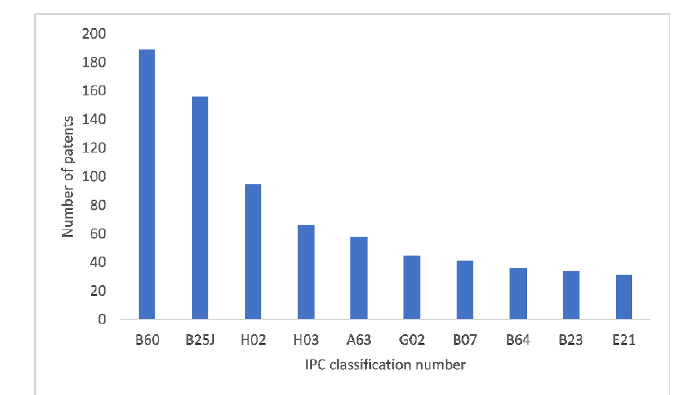
Fig. 13 Definitions of the IPC number in medical technology.